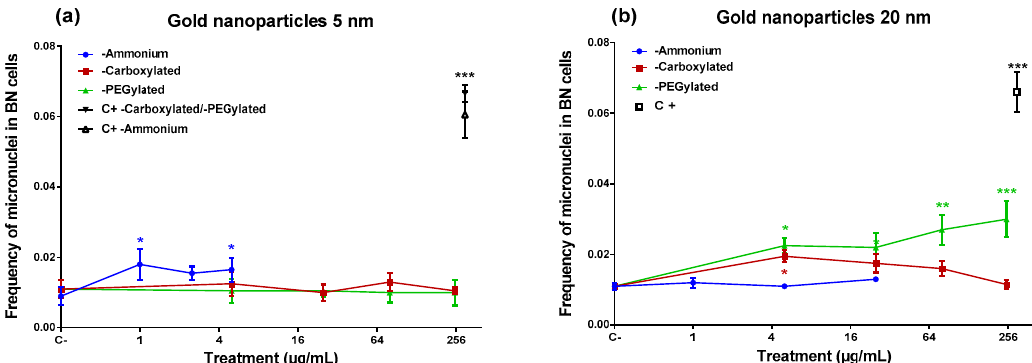
Figure 3. Micronucleus frequency in binucleated (BN) BEAS-2B cells after a 48-h treatment with gold nanoparticles (core diameter: ~5 nm ( a ) or ~20 nm ( b )). Treatment is expressed as the antilog of Log 2 of the dose. Mitomycin C (150 ng / mL) was used as a positive control (C + ; symbol on the right). The symbols represent means ± SD. Statistical significance in comparison with control cultures (Fisher’s exact test, two-tailed): * p < 0.05; ** p < 0.01; *** p < 0.001.